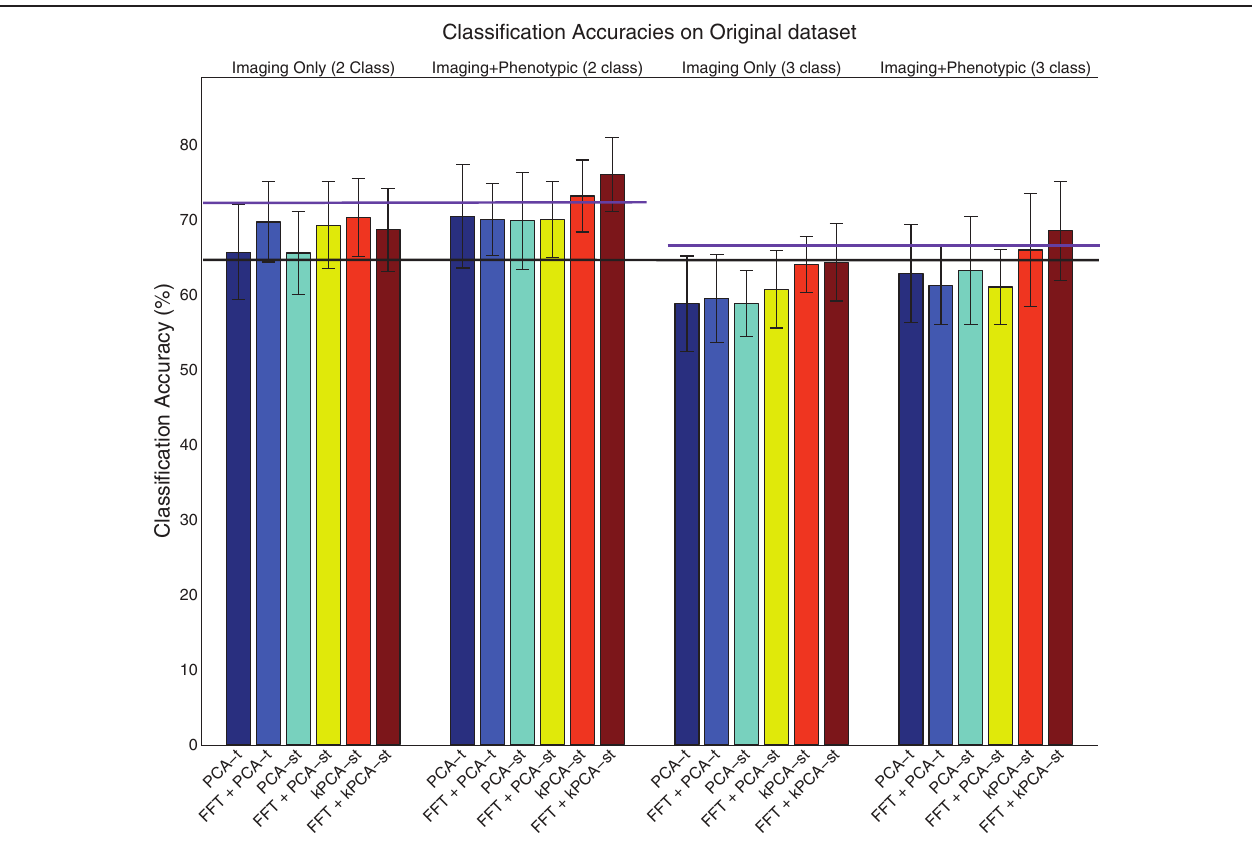
FIGURE 6 | Visualization of the results on the original dataset (Table 2), where the error bar is ± the standard deviation. The purple lines denote the phenotypic data classification accuracy in the two class (left) and three class (right) setting, and the black line denotes the baseline in both the two and three class